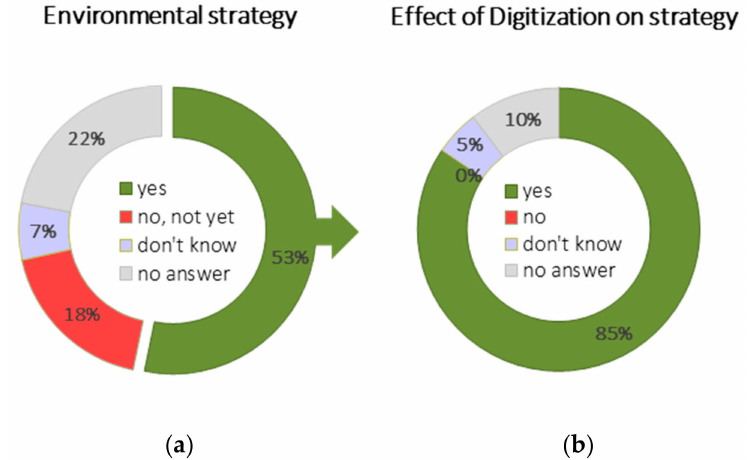
Figure 1. Companies having implemented an environmental strategy ( a ); and share from those, who expect digitalization to affect the respective environmental strategy ( b